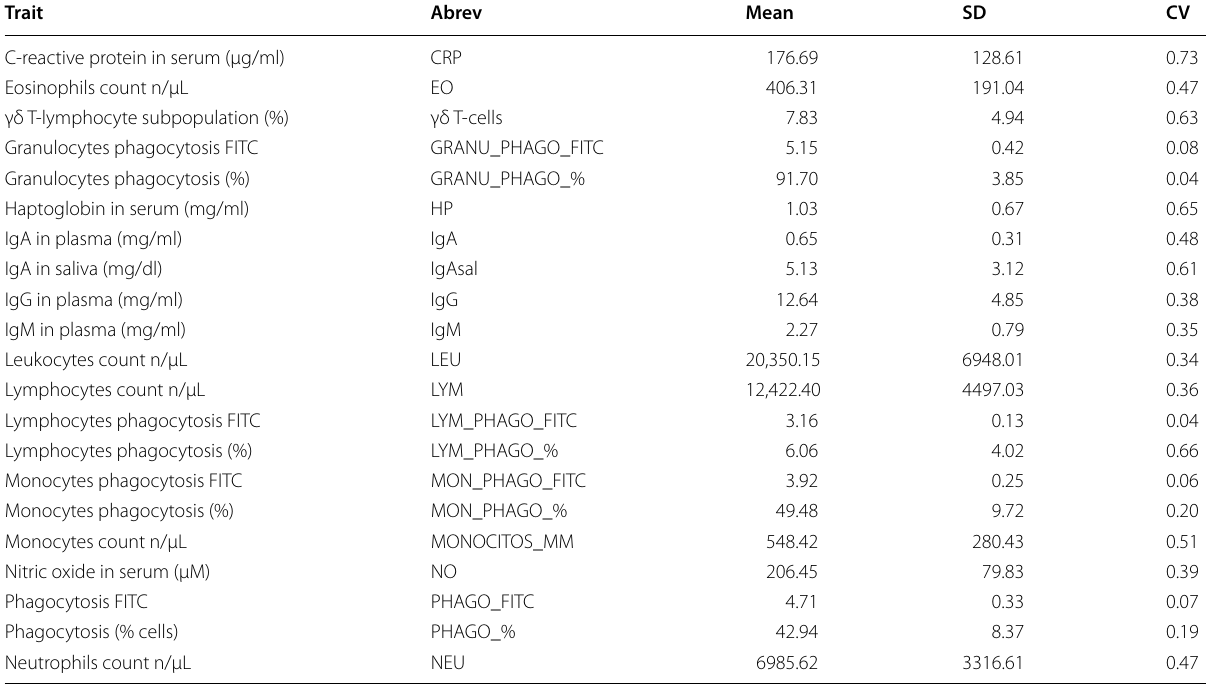
Table 1 Descriptive statistics, mean, standard deviation (SD) and coefficient of variation (CV) of the 21 analyzed traits